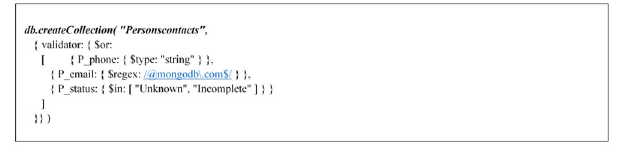
Fig 10. Json example for specifying validator